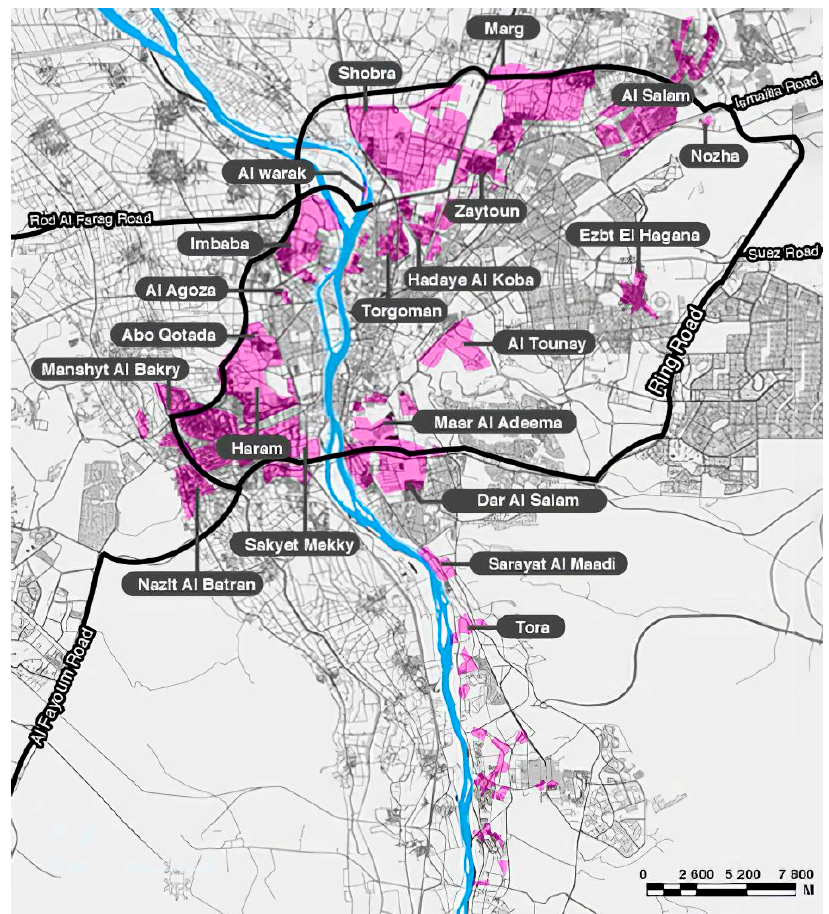
Figure 1. Greater Cairo unplanned areas. Map drawn by the authors based on data collected from [31], the base map for Greater Cairo is adapted from dreamstime.com with royalty-free licenses permission.